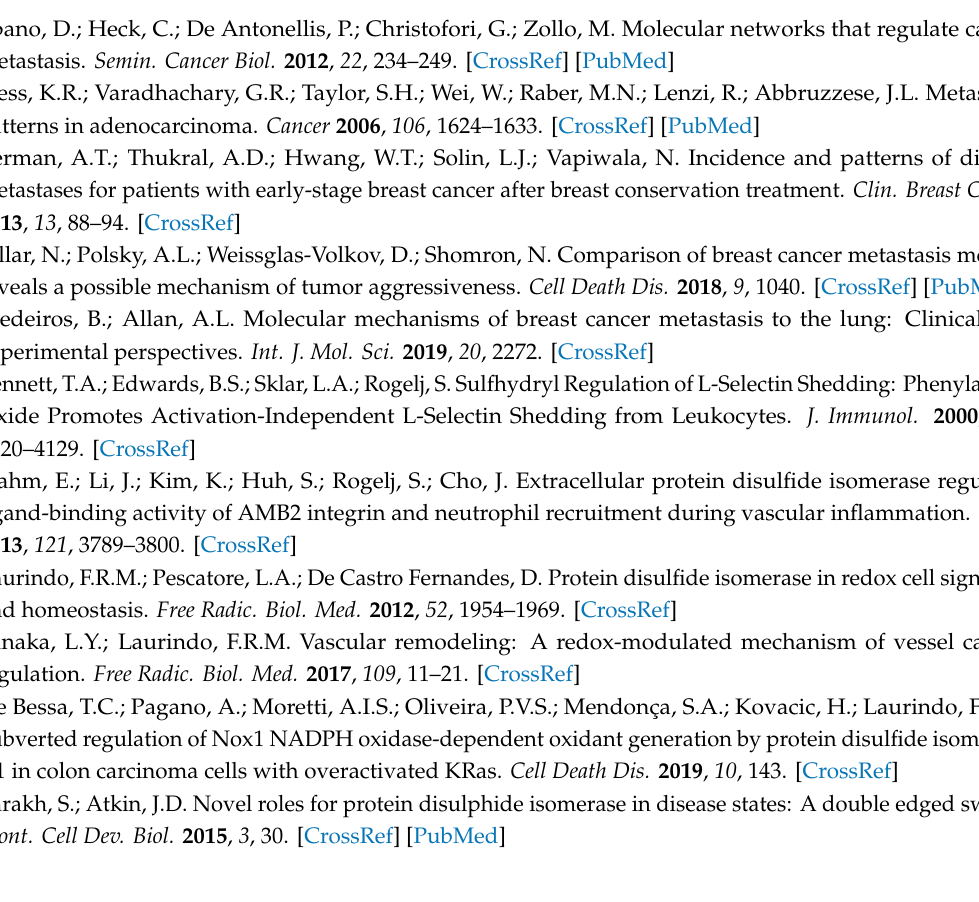
Figure S1 : The activity of the shPDIA1 sequence in a stable transduced breast cancer cell lines, Figure S2 : The e ff ect of PDIA1 inhibition by bepristat 2a on hLMVEC, MCF-7 and MDA-MB-231 cells viability assessed after 24 and 48 h, Figure S3 : The e ff ect of PDIA1 inhibition on caspase 3 / 7 activity in breast cancer cells, Figure S4 : The e ff ect of PDIA1 inhibition on cell cycle distribution of breast cancer cells, Figure S5 : The e ff ect of PDIA1 inhibition on cell cycle distribution of breast cancer cells, Figure S6 : The e ff ect of PDIA1 inhibition on ICAM-1 expression. Figure S7 : The e ff ect of PDIA1 inhibition on mitochondrial respiration. Figure S8 : The whole western blot